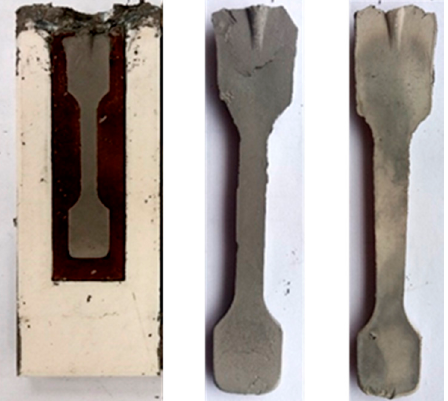
Figure 9. Copper plated ABS mold with green and sintered MIM parts.